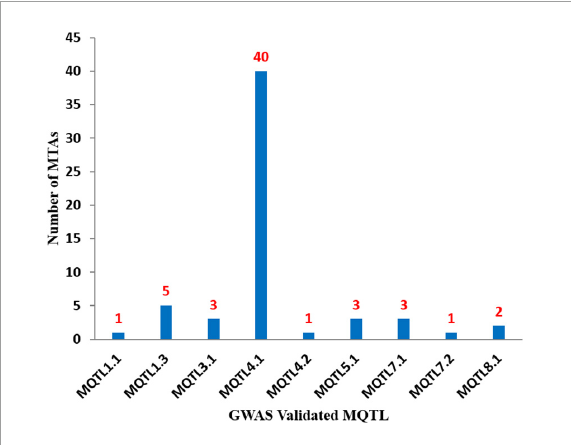
FIGURE4 Number of known GWAS based MTAs which validated each of 9 MQTLs identified during the present study. The figure shows maximum number of MTAs validated for